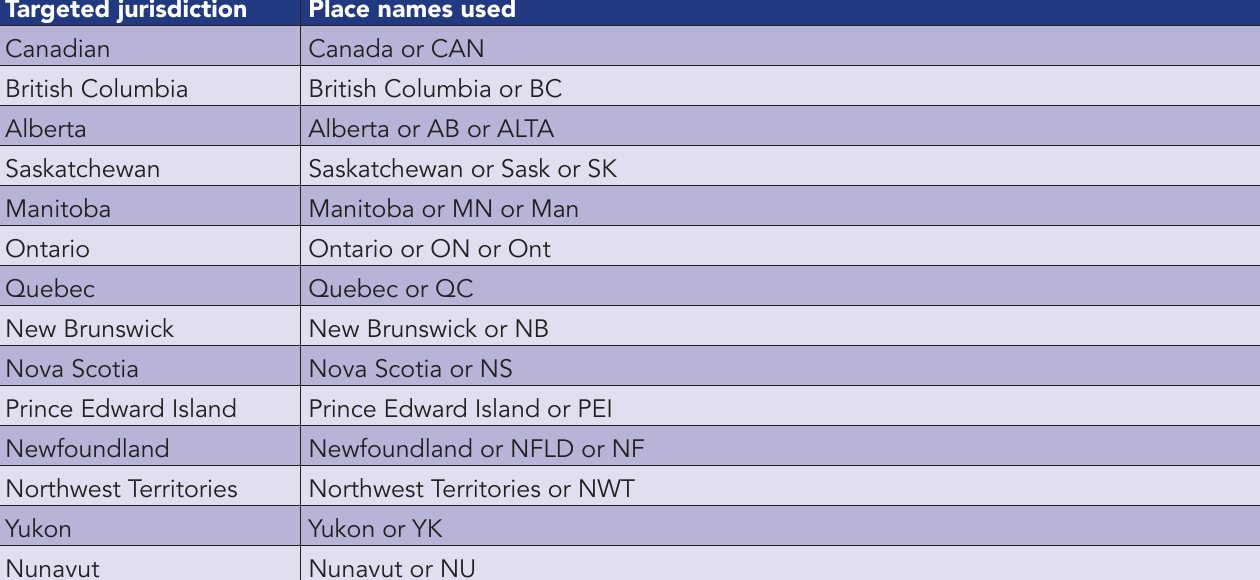
Table 7: List of Place names used in Google search Targeted